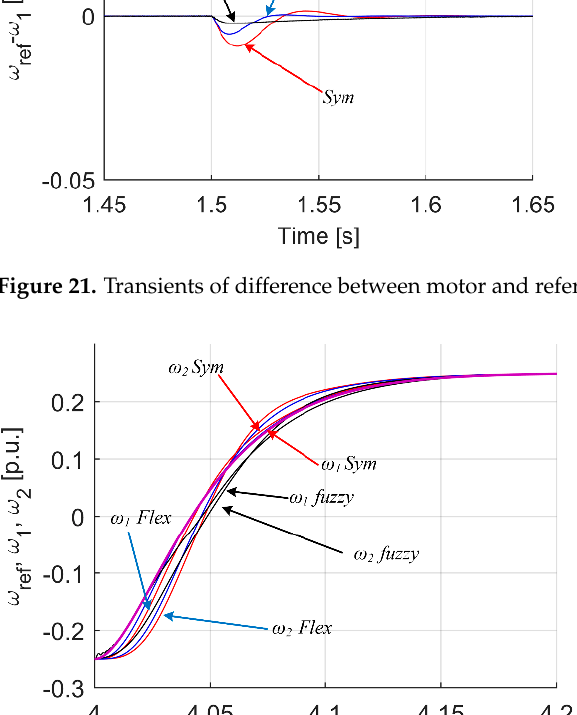
Figure 22. Transients of motor, load and reference speed for case of reference speed change.